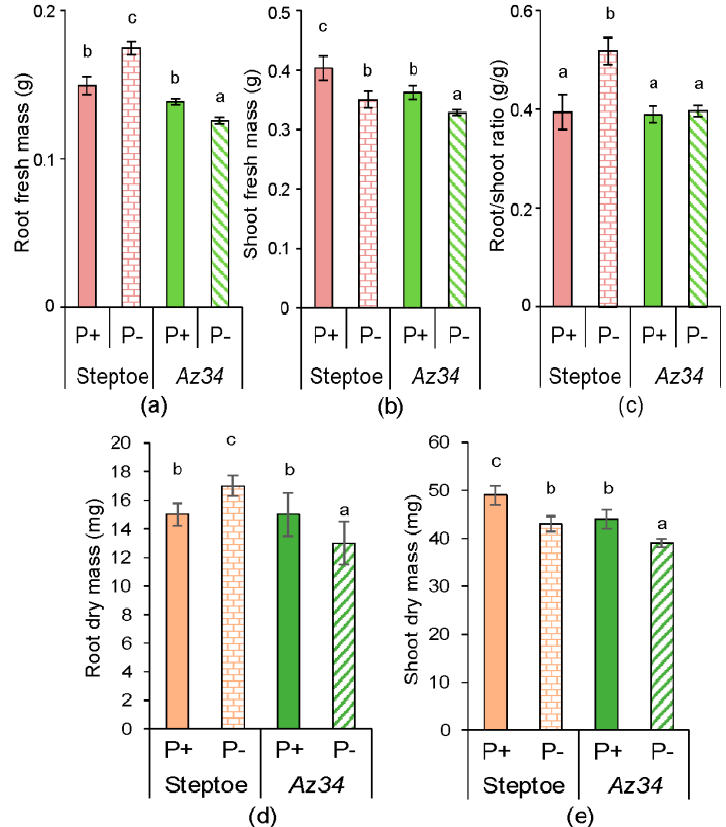
Figure 1. Root ( a , d ) and shoot ( b , e ) fresh ( a , b ) and dry ( d , e ) mass and root/shoot fresh mass ratio ( c ) of 7-days-old of WT (cv. Steptoe) and Az34 plants grown for 4 days on nutrient solutions with (P+) or without (P − ) phosphate. Bars are means ± S.E. of n = 20, with significant ( p ≤ 0.05) differences between all genotype/treatment combinations marked with different letters (ANOVA, LSD).